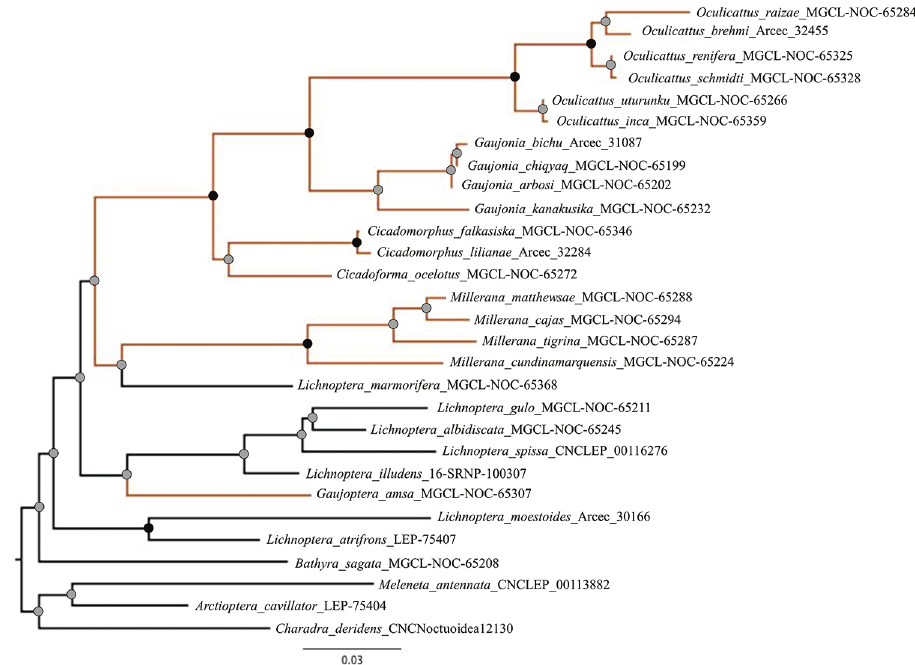
Figure 1. Maximum likelihood tree showing relationships between the Gaujonia genus group and the rest of the other jaguar moth genera based on the cytochrome c oxidase I gene (COI) marker. Nodes with black circles represent high support (UFBoot ≥ 95 and SH-aLRT ≥ 80). Nodes with gray circles represent low support (UFBoot < 95 and SH-aLRT < 80). Black branches constitute the